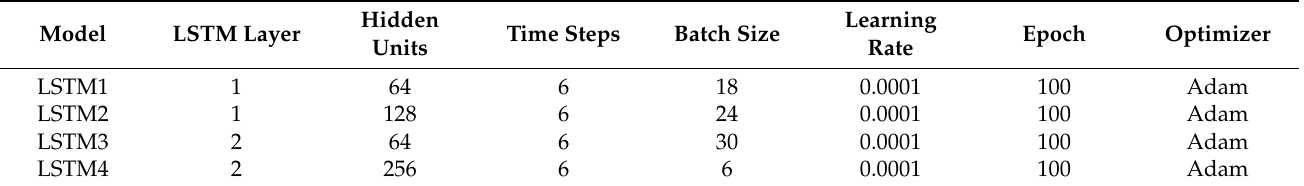
Table 4. List of the best selected hyperparameters for each LSTM model using GridSearchCV. We fixed the time steps, learning rate, and optimizer in this study.